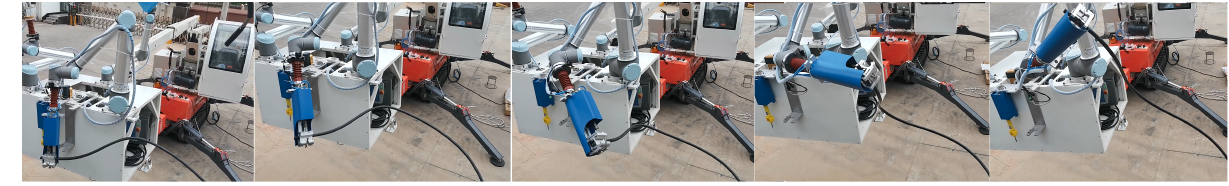
Figure 8. The twisting of a drainage line during installation.